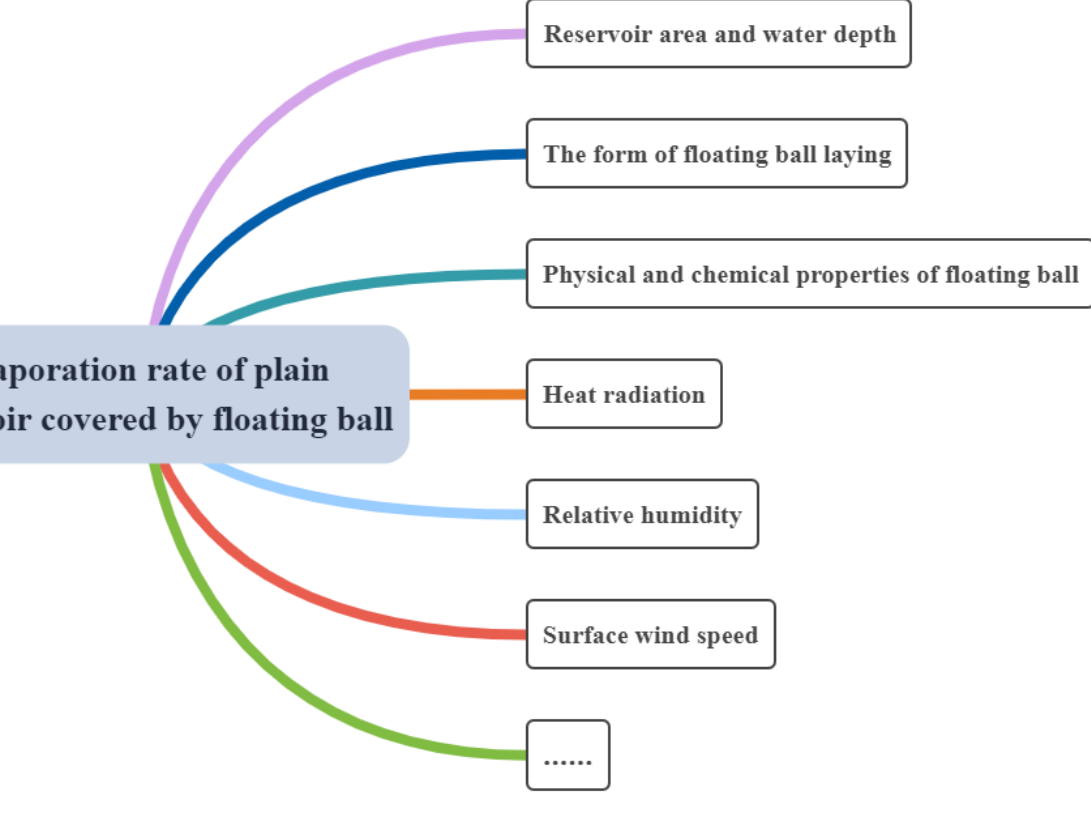
Figure 3. Main influencing factors of evaporation rate of plain reservoir covered by floating balls. Note: “......” indicates other factors affecting evaporation rate in small-sized water bodies, but their importance is weaker in reservoirs.